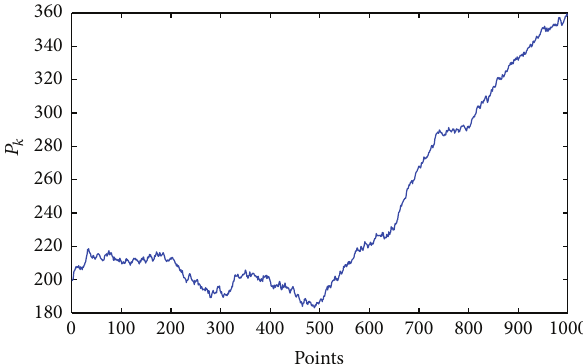
Figure 1: Simulation price data 𝑃 𝑘 made from model (13).